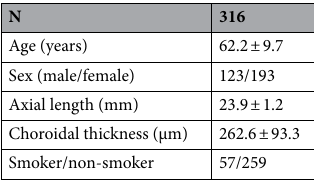
Table 1. Characteristics of study participants.